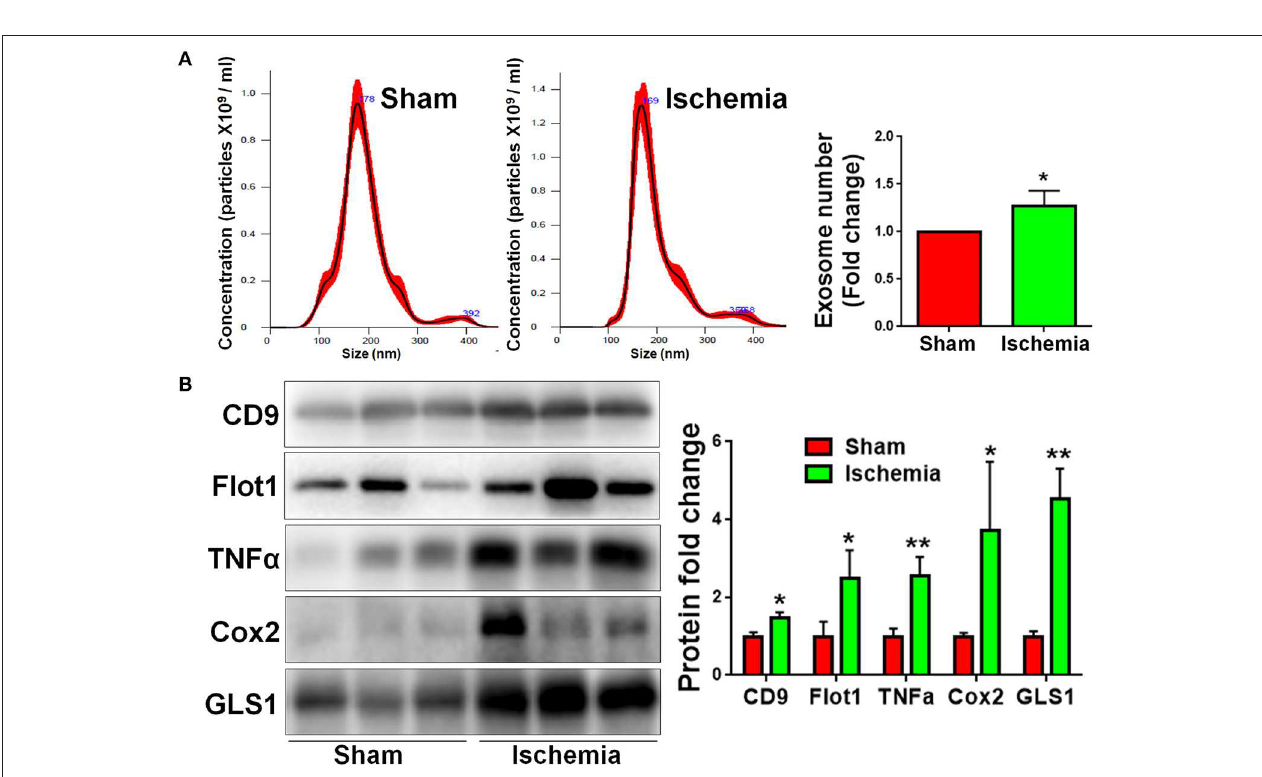
FIGURE 4 | Focal cerebral ischemia induces exosome release. Exosomes were collected from ischemic and sham brain tissues for NTA (A) and western blot (B) analyses. (A) The concentration of exosome suspension was determined by NTA. (B) Representative immunoblots of CD9, Flot1, TNF α , Cox2, and GLS1 were shown along with quantifications of protein expression levels. Western blot data were presented as fold change compared with those in sham rat brains. Error bars denote s.d. from triplicate measurements. * p < 0.05 and ** p < 0.01 by two-tailed t -test ( n = 9).